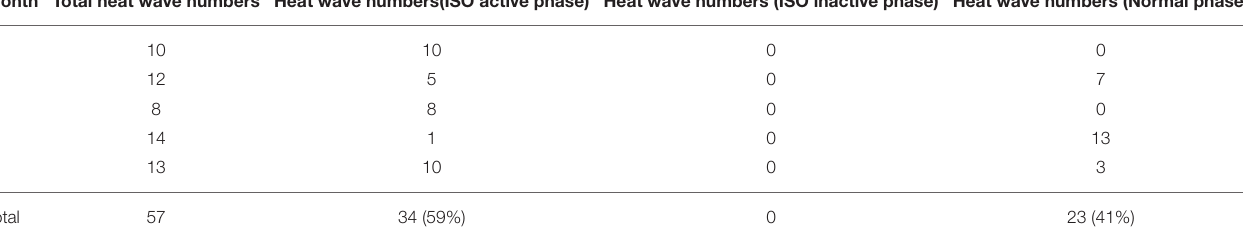
TABLE 2 | Numbers of total heat wave events and heat wave events in the active and inactive phase of ISO in eastern China based on 97.5th percentile threshold for each month during